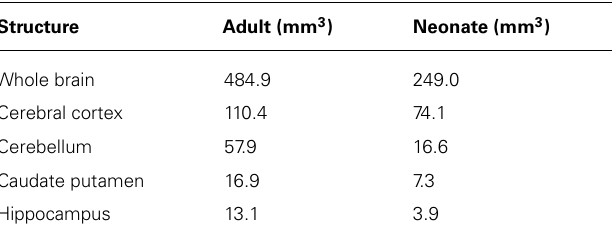
Table 4 |Volumes of the whole brain, cerebral cortex, cerebellum, caudate putamen, and hippocampus in the adult and neonatal naked mole-rat.